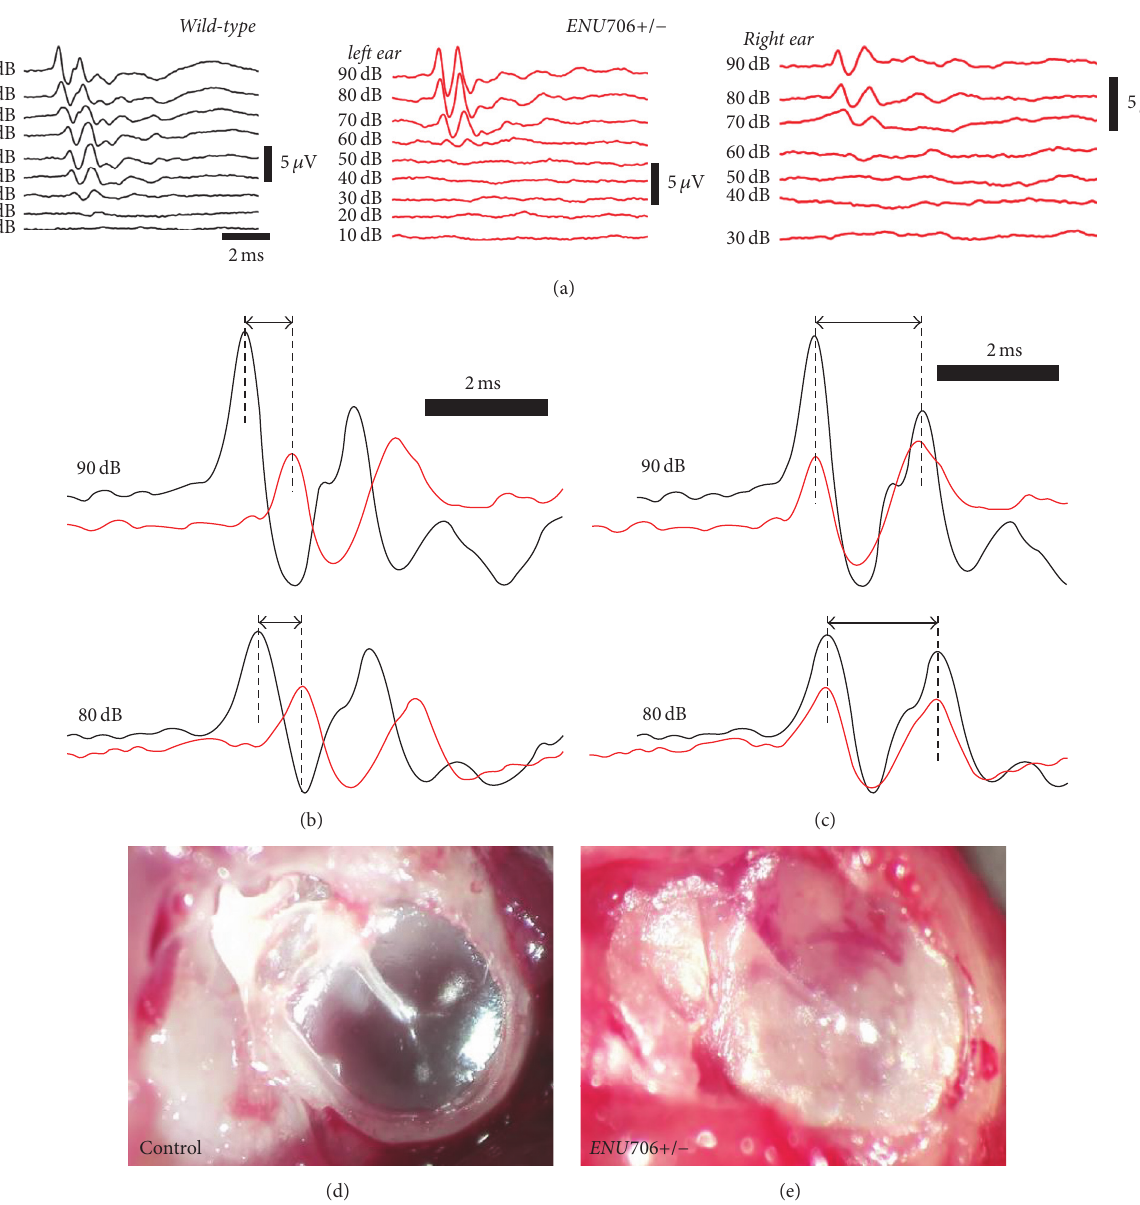
Figure 2: The ENU706 mice possessed moderate hearing loss. (a) A representative case showed the click ABR test in control and ENU706 mice. A control mouse possessed a hearing threshold as low as 20 dB SPL. An ENU706 mouse had 50dB SPL hearing threshold at the left ear and 60dB SPL hearing threshold at the right ear. (b) The onset of ABR responses was 0.36 milliseconds later in mutant than that in control mouse. (c) The duration between peaks I and II was not altered obviously in mutant compared to the control. The traces analyzed in (b) and (c) were from the same recordings shown in (a). In (a), (b), and (c), control was shown in black and ENU706 in red. In difference with the control (d), the heterozygous ENU706 mice with elevated ABR responses were found to have otitis media